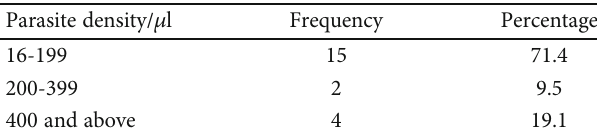
Figure 2: Prevalence of malaria using RDT and microscopy. Table 2: Falciparum parasite density related to microscopy